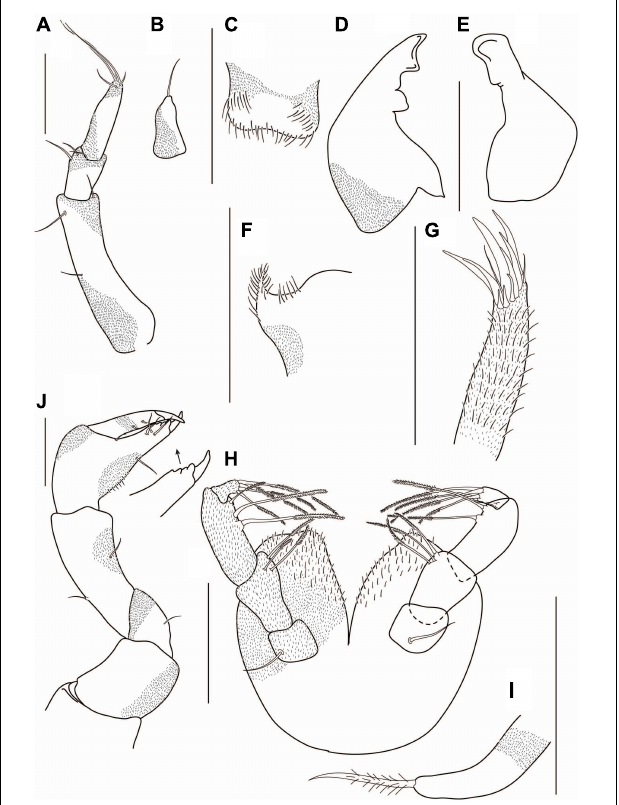
FIGURE 15 | Agathotanais paleroi n. sp., neuter, paratype ( A,C,F,J : NHM 58022; B,D,E,G–I : ZMH K-61177). (A) antennule; (B) antenna; (C) labrum; (D) left mandible; (E) right mandible; (F) labium; (G) maxillule; (H) maxilliped; (I) epignath; (J) cheliped. Scale bars: (A–I) = 10 µ m, (J) = 100 µ m.